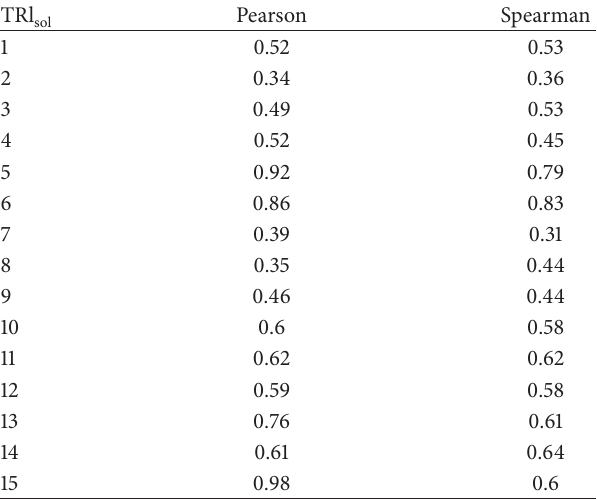
Table 9: TriGen algorithm control parameters for Mouse GDS4442 Dataset.